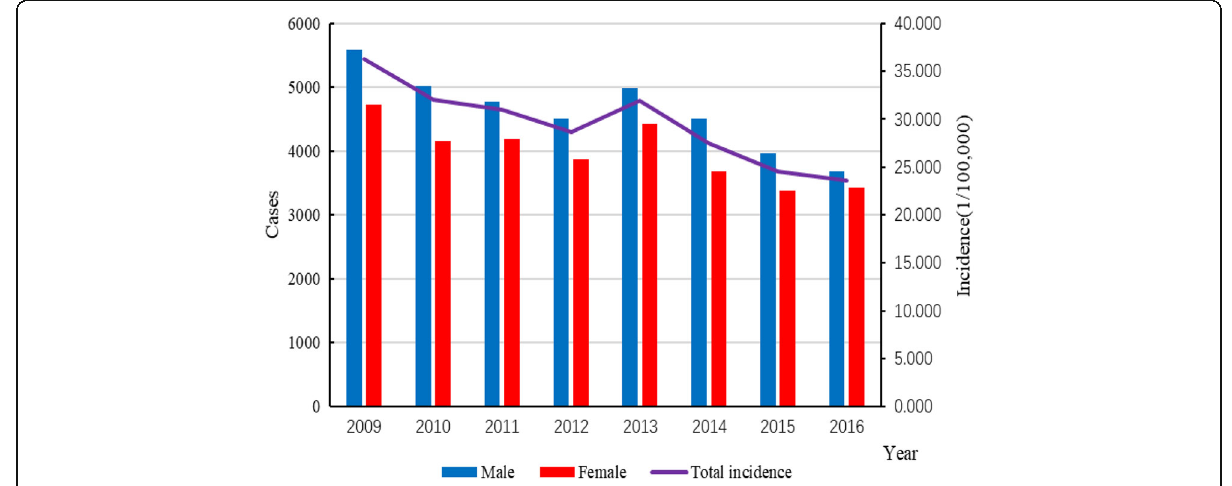
Fig. 2 Total incidences and gender distribution of bacillary dysentery in Chongqing from 2009 to 2016